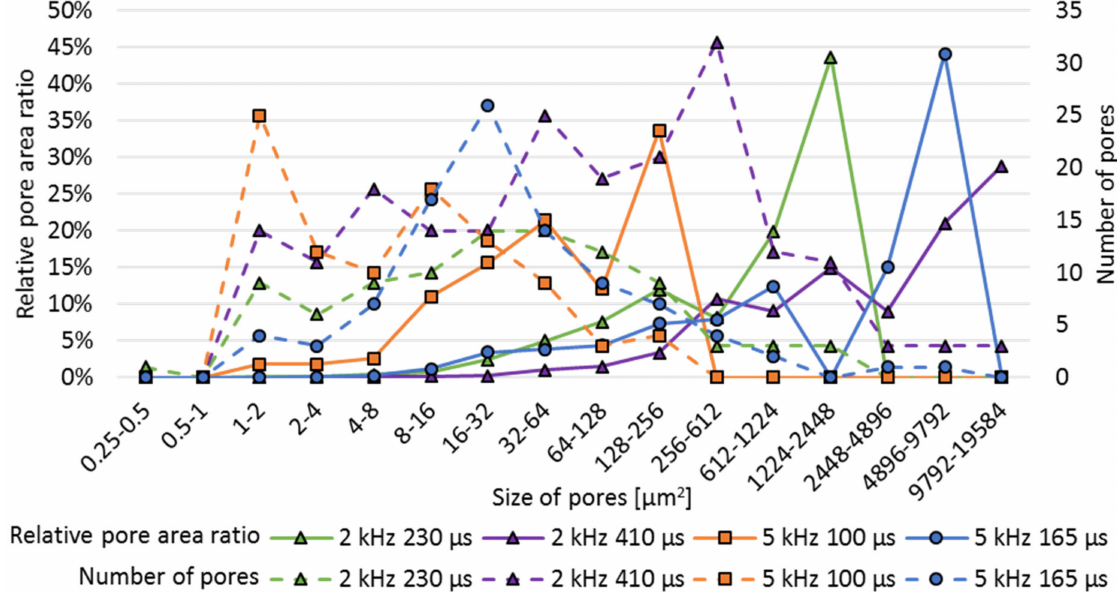
Figure 17. Pore size distribution depending on the modulation frequency f m and modulation time t m . The formation of pores within the remelting zone has to be differentiated into initial pores from the L-PBF process and process pores, like gas porosity from the polishing process. Several medium and large-sized pores, which were found in the remelted zone, are located at the border of the remelting zone and are partially in the unmolten zone below the remelting zone of the polishing process, see Figure 18. The area of the pores seems to extend by remelting this surface layer, when calculating the dimension of a circular initial L-PBF pore by using several measuring points at the unmolten bottom of the pores. When comparing the calculated red dotted circle at the microscopic images of Figure 18, a growth of the pore in the remolten area in surface direction can be assumed.